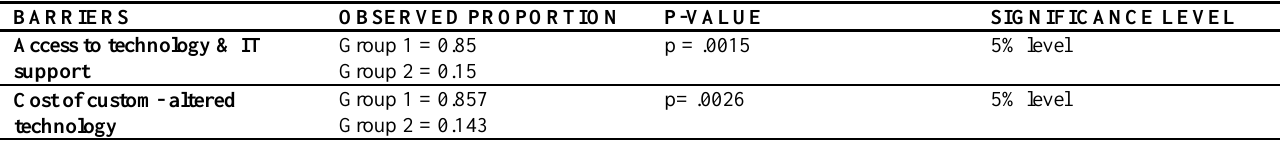
Table 10: Possible barriers to considering/implementing FWP